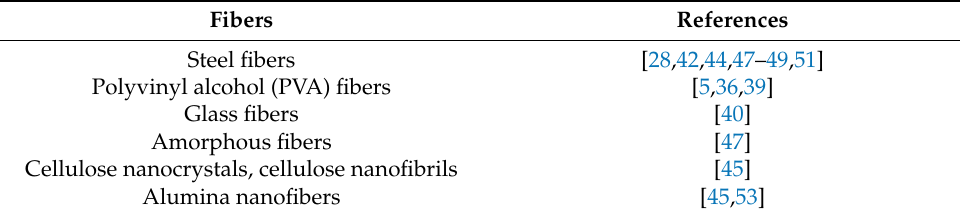
Table 8. The case of specimens mixed with CA and